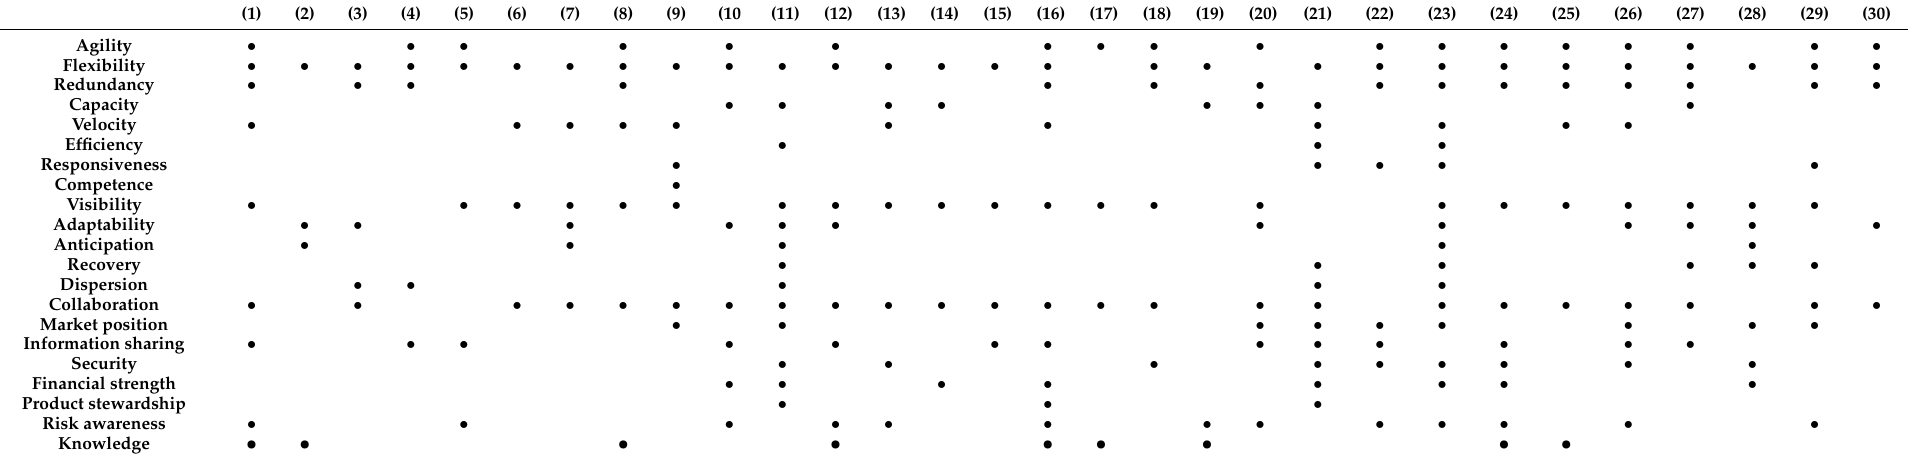
Table 1. The constituent elements of resilience capacities by